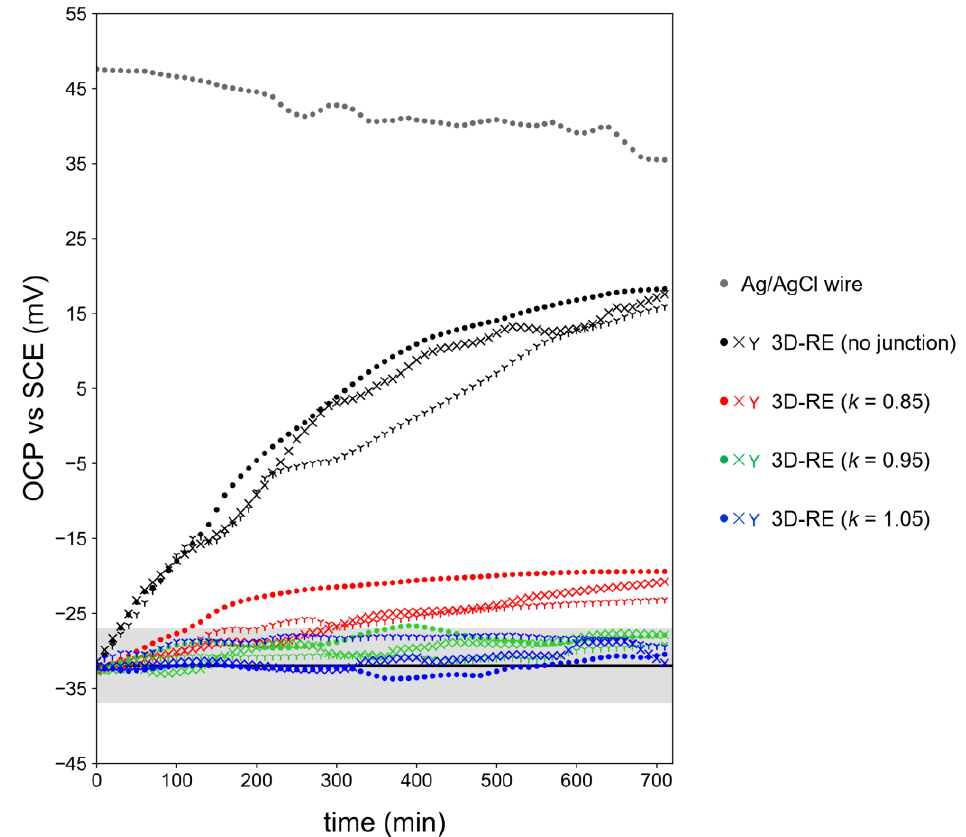
Figure 5. Potential stability of 3D-printed reference electrodes (3D-REs) with junctions printed using different extrusion ratios ( k = 0.85, 0.95, 1.05). Open-circuit potential (OCP) measurements vs. saturated calomel electrode (SCE) were taken every 10 min over a 12-h period in 0.1 M KCl. 3D-REs from three separate fabrication batches were used for each type of electrode. The black solid line corresponds to a potential of −32 mV, while t he shaded region corresponds to the acceptable OCP drift region of ± 5 mV. For comparison, potential stabilities of a 3D-RE without a junction and a Ag|AgCl wire pseudo-reference electrode are also shown.